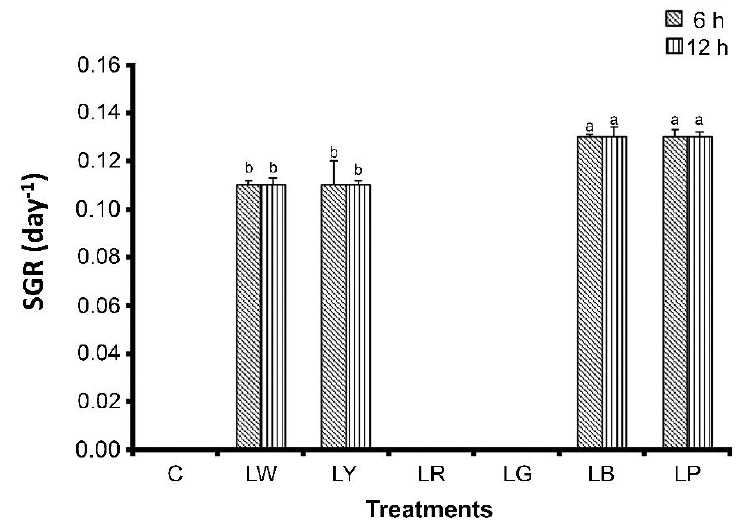
Figure 3. Growth of G. columna after illumination under different light sources. Goniopora columna specimens were treated with LW, LG, LY, LB, LR, or LP for 6 h or 12 h per day. The control group (C) was maintained in dark conditions. The specimens were weighed once a week for 8 weeks, and the specific growth rates (SGRs) were calculated. Different letters indicate significant differences among groups ( p < 0.05). Values are expressed as means ± standard deviations ( n = 30).